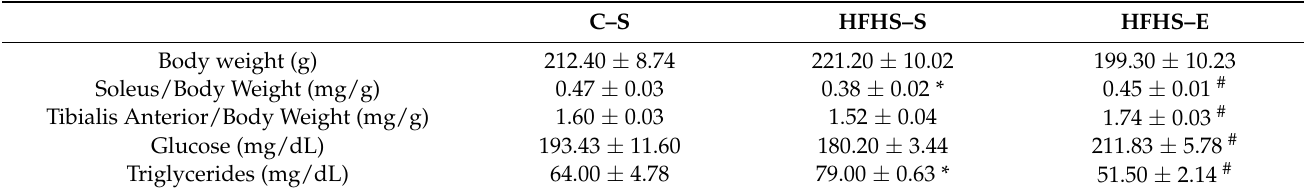
Offspring from control diet sedentary group (C–S); offspring from high-fat, high-sucrose diet sedentary group (HFHS–S); offspring from high-fat, high-sucrose diet exercised group (HFHS–E), n = 6. Data are expressed as the mean ± SEM. Statistically significant differences ( p ≤ 0.05) are indicated as follows: * vs. C–S, # vs.